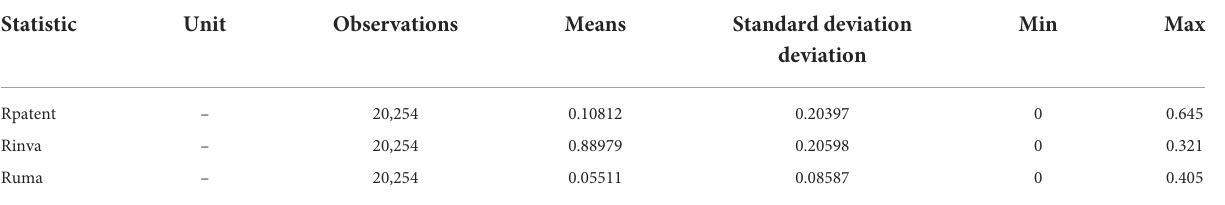
TABLE 4 Descriptive statistics of surrogate variables.